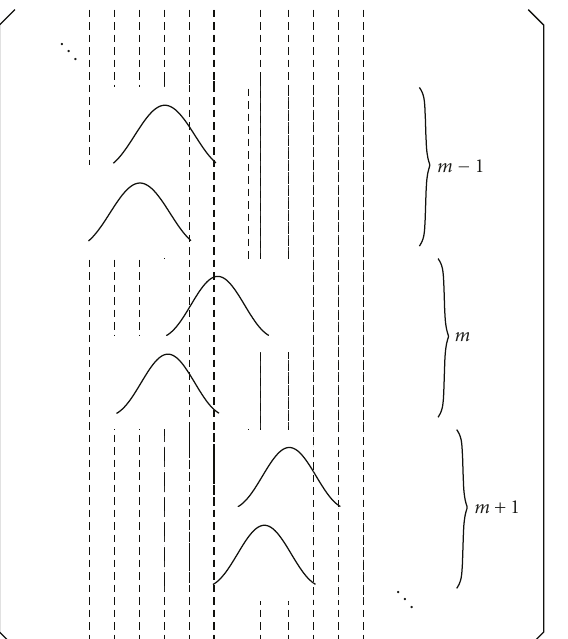
Figure 8: Window matrix for Figure